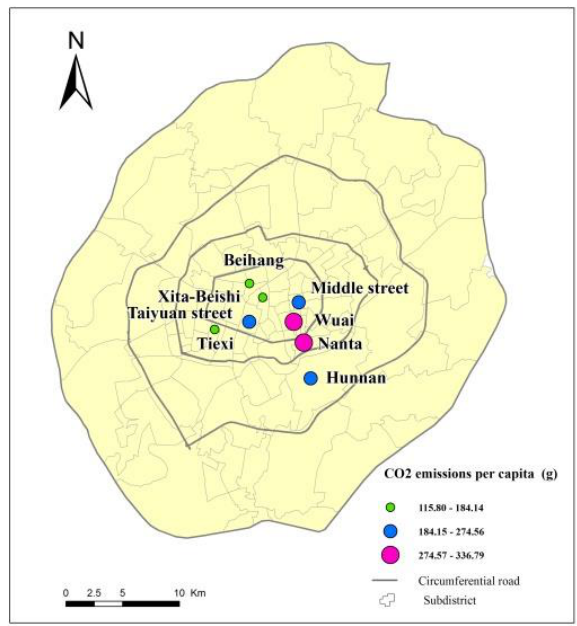
Figure 2. CO 2 emissions per trip to the eight commercial centers.